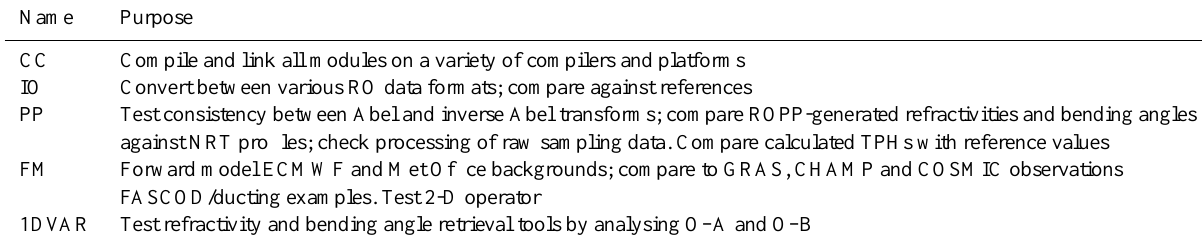
Table 7. Elements of the ROPP TEST